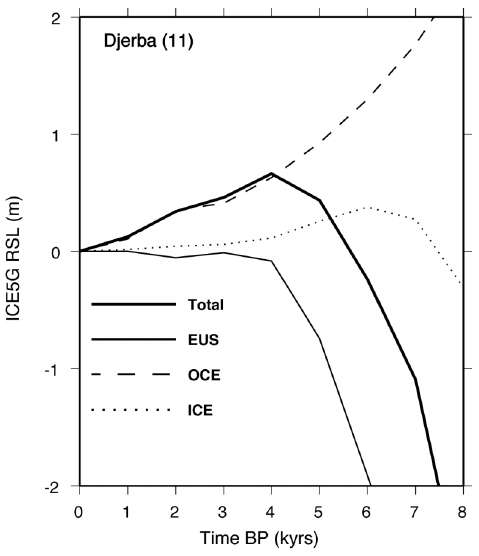
Fig. 6. Ice- and ocean-load induced components of RSL for the site of Djerba (see map of fig. 3a) ob- tained using model ICE5G